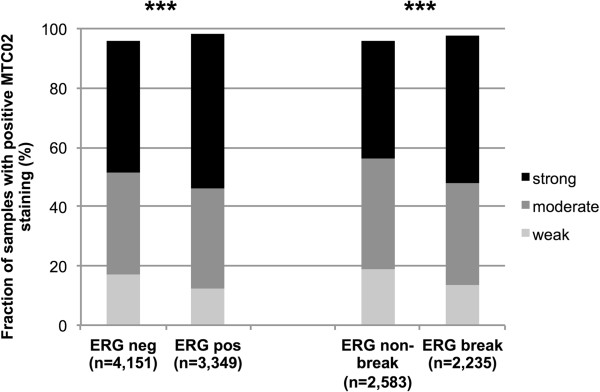
Relationship of MTC02 expression with ERG-fusion status probed by IHC and FISH. Strong MTC02 immunostaining was slightly more prevalent in ERG fusion positive prostate cancers, regardless if the ERG status was obtained by IHC or FISH analysis (p < 0.0001 each).